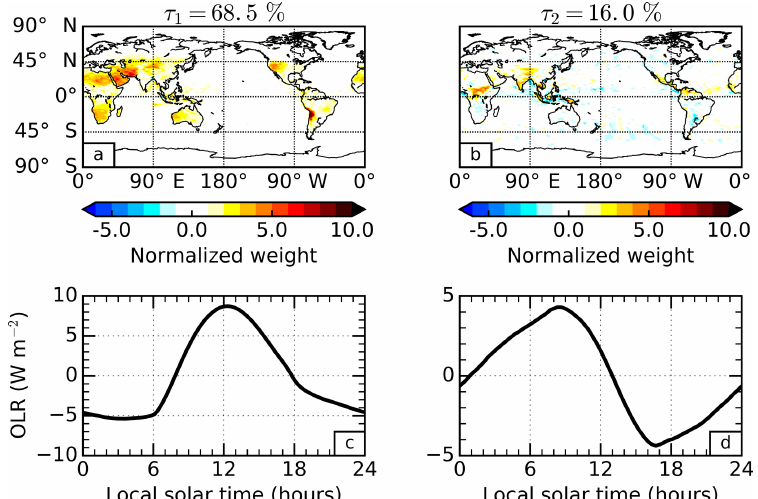
Figure 1. Principal component analysis of the global outgoing long-wave radiation (OLR) diurnal cycle for September 2010 in the Met Office model. The empirical orthogonal functions ( a and b ) and principal components ( c and d ) are presented for the first ( a and c ) and second ( b and d ) most dominant patterns of variability. The percentage variance explained by each pattern is stated above the corresponding empirical orthogonal